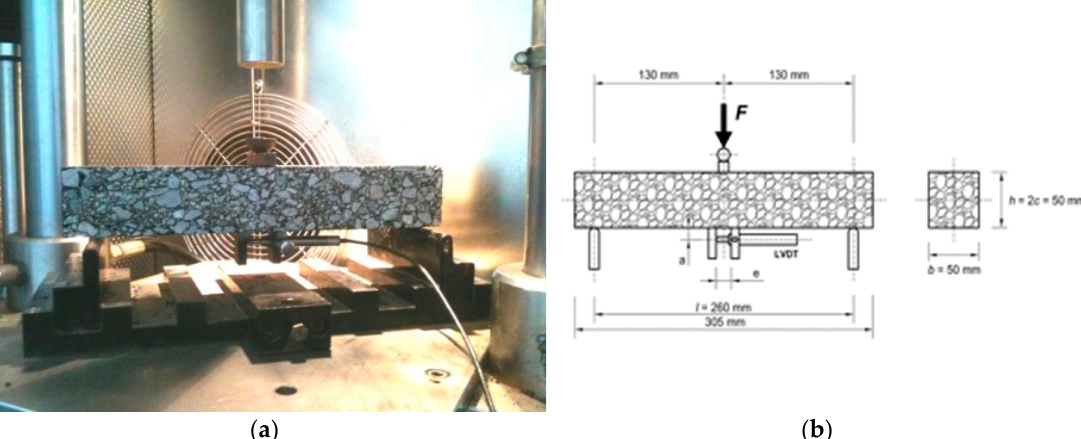
Figure 4. Bending Beam Creep Test: ( a ) specimen mounted in the Bending Beam Creep tester; ( b ) schematic view [39].